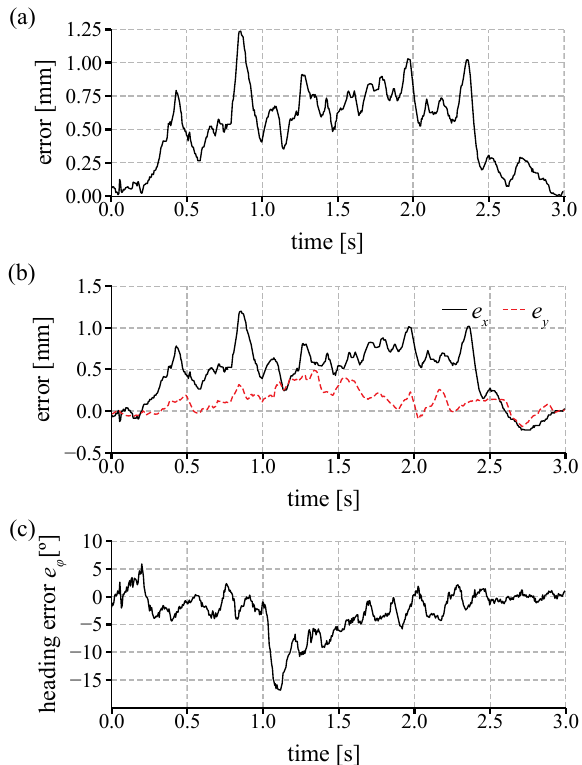
(cid:113) e 2 x + e 2 y ,